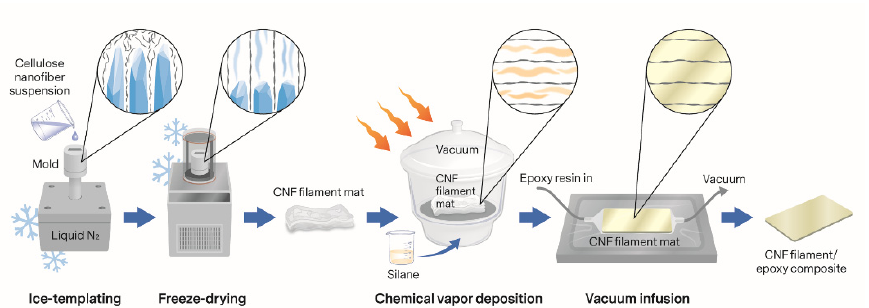
Figure 1. Process schematic. Ice-templating was used to orient the cellulose nanofibers (CNFs) into thin filaments, and dry filament mats were obtained after freeze-drying. The filament surfaces were covered with an aminosilane, and the treated filament mats were impregnated with a bio-epoxy resin to form composites.